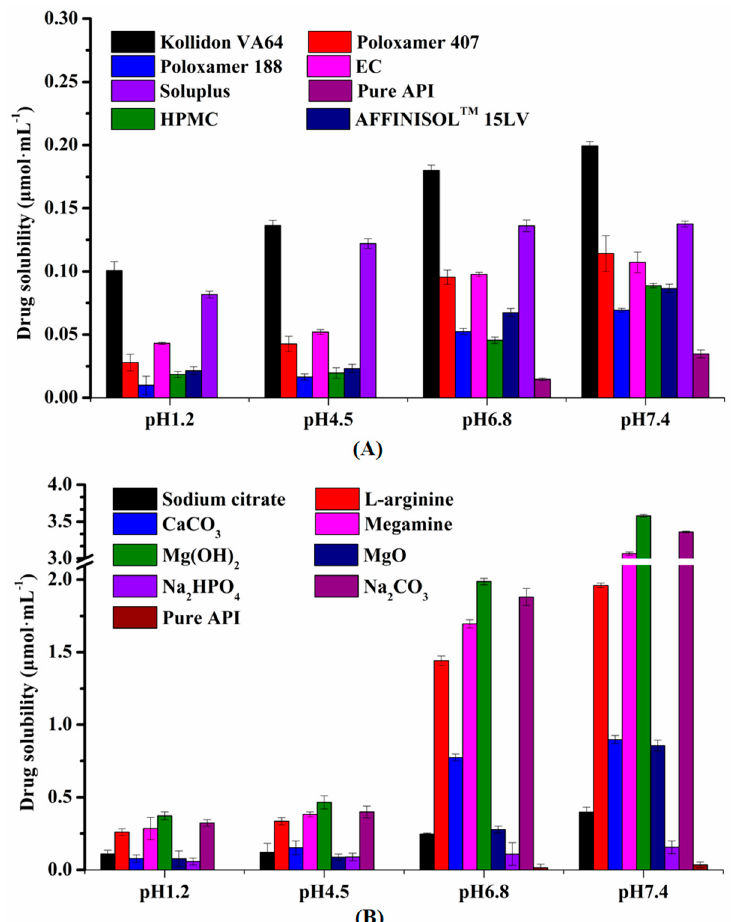
Figure 2. Solubility screening of polymers and alkalizers. ( A ) The solubility of glycyrrhetinic acid (GA) with various polymers in different pH buffers ( n = 3). ( B ) The solubility of GA with various alkalizers in different pH buffers ( n = 3).